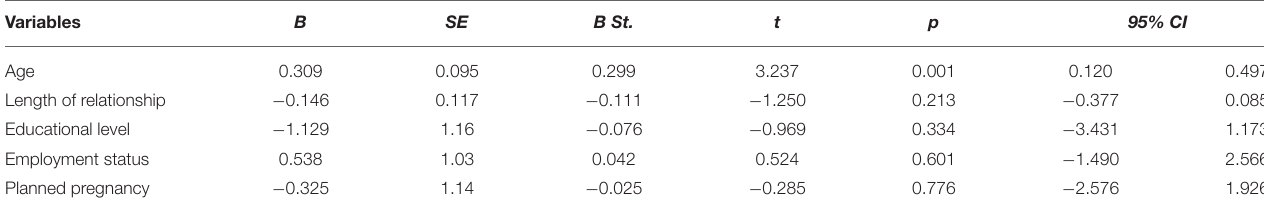
TABLE 1 | Summary of the linear regression analysis with socio-demographical characteristics as independent variables for PPD score.